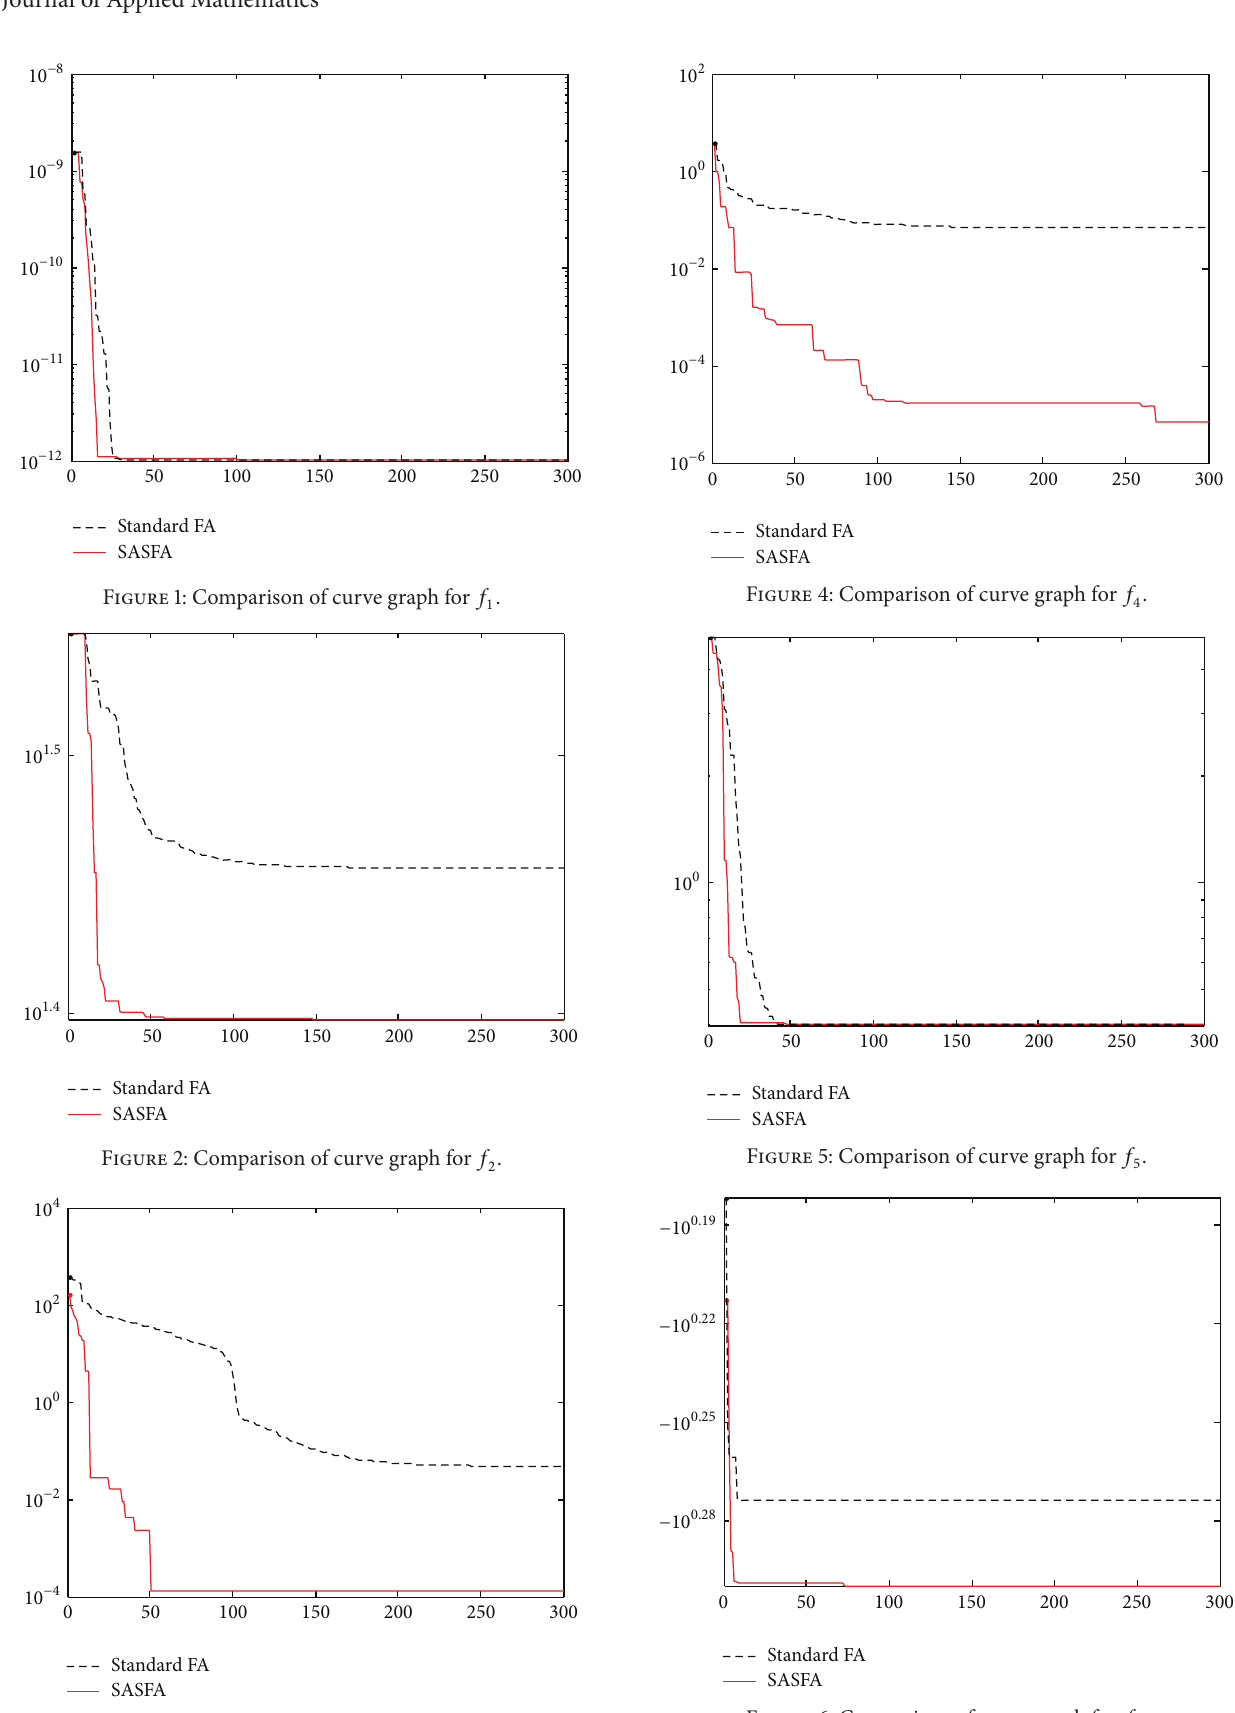
Figure 3: Comparison of curve graph for 𝑓 3 .